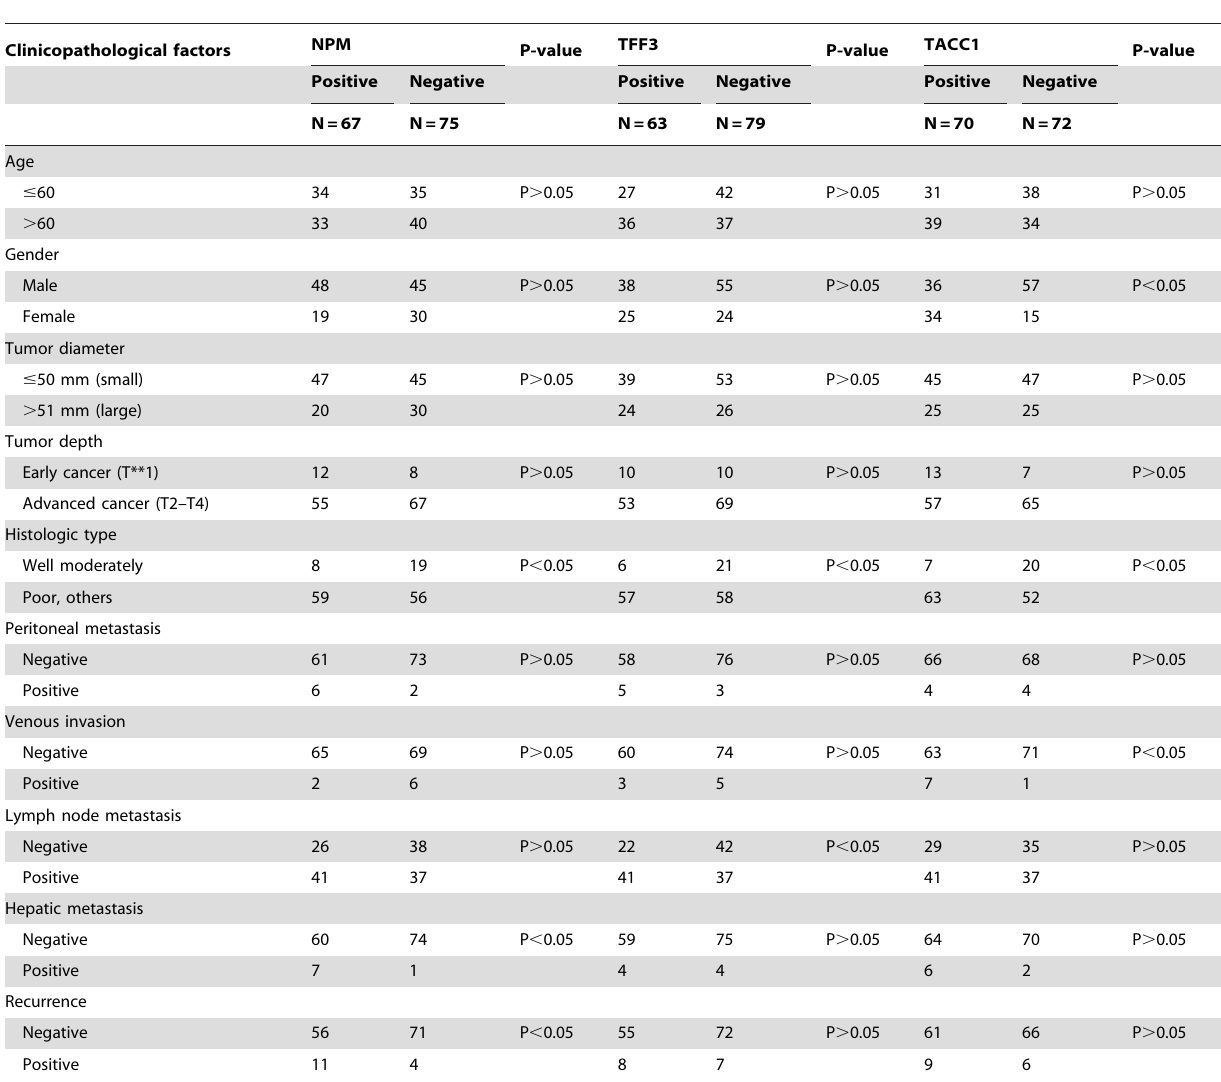
Table 2. Correlation between clinicopathological factors and NPM, TFF3 and TACC1 expressions.